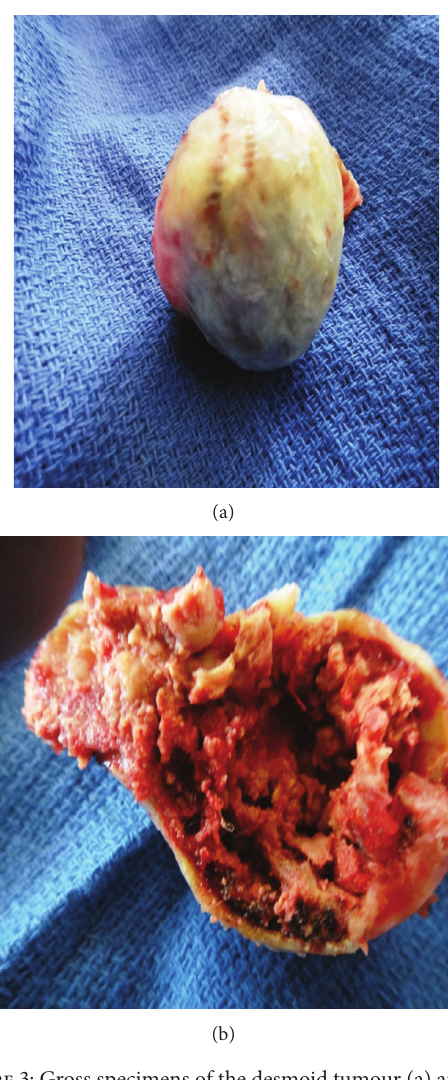
Figure 3: Gross specimens of the desmoid tumour (a) and (b).